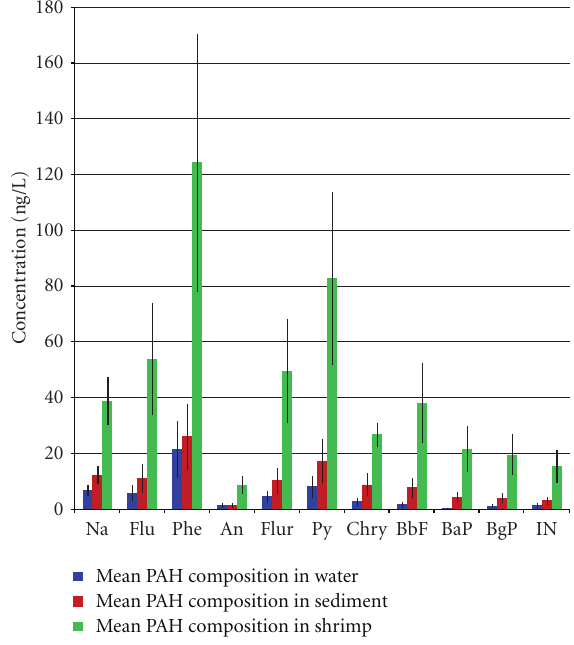
Figure 2: Mean PAH concentrations with 95% confidence interval.